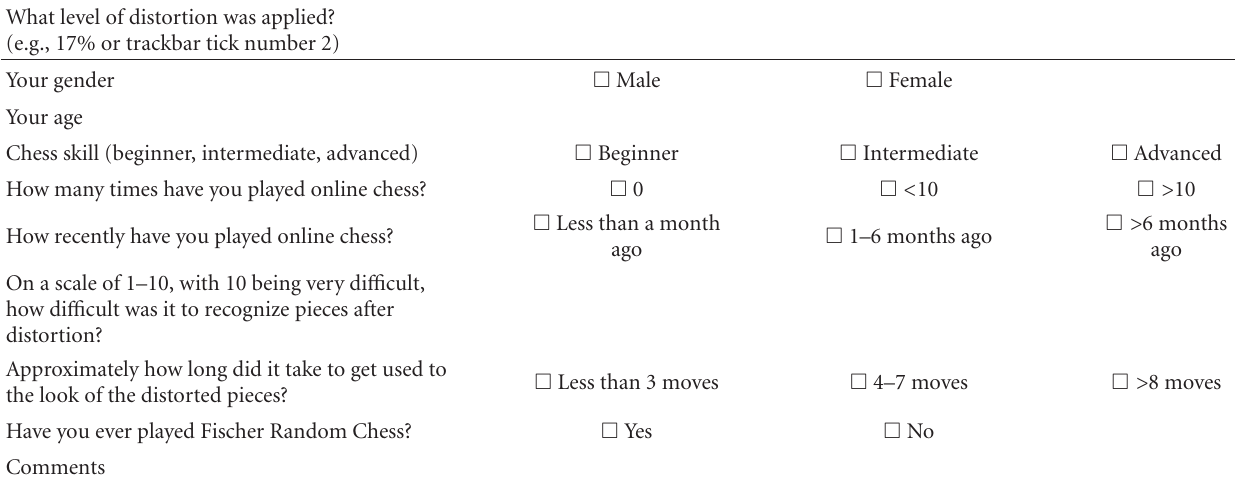
Table 1: Feedback form embedded non-interactive CAPTCHA for Fischer Random Chess. Adjust the distortion to desired level. Try playing the game for at least 5–10 minutes. Feedback form used to gather information about the di ffi culty of the CAPTCHA tests. What level of distortion was